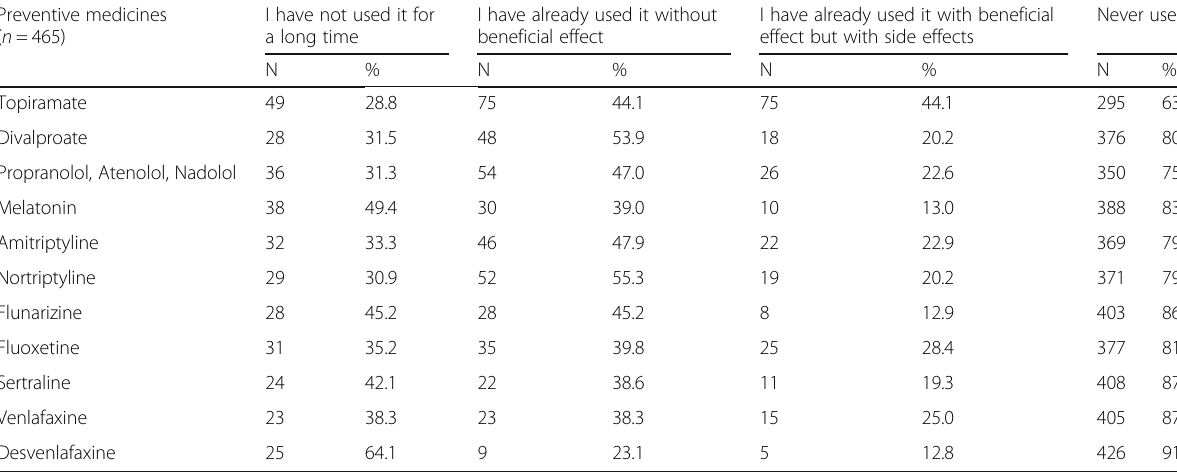
Table 5 Patients ’ experience with preventive